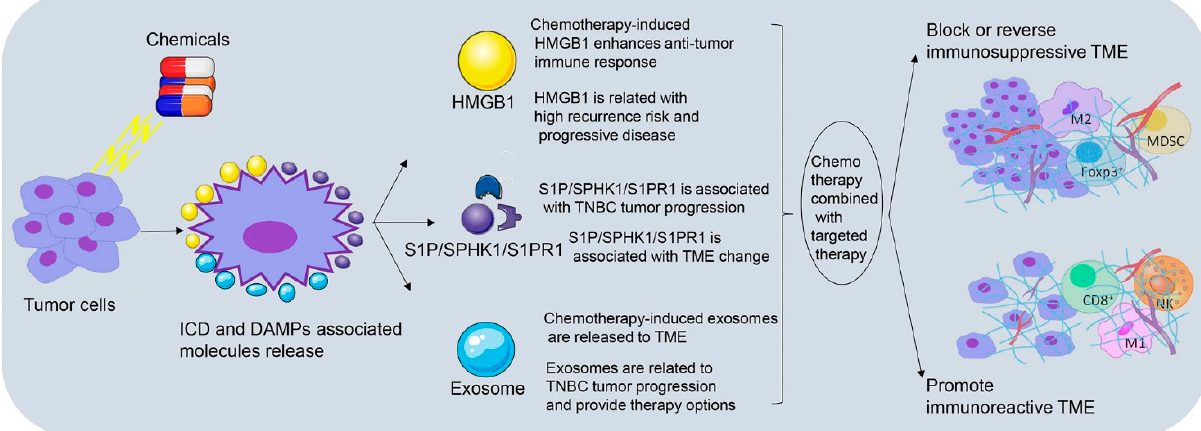
Figure 2. Chemotherapy-induced immunogenic cell death and immunomodulation in TNBC. Chemotherapy induces immunogenic cell death (ICD), and then promotes the release of damage-associated molecular patterns (DAMPs) including high mobility group box1 (HMGB1), exosomes and sphingosine-1-phosphate receptor 1 (S1PR1) by damaged or activated cells. Chemotherapy combined with targeted therapy could enhance anti-tumor immunity through promoting function of immunoreactive lymphocytes and blocking or reversing function of immunosuppressive cells. (ICD, immunogenic cell death; DAMPs, damage-associated molecular patterns; HMGB1, high mobility group box1; S1P, sphingosine-1-phosphate; SPHK1, sphingosine kinase 1; S1PR1, sphingosine-1-phosphate receptor 1; TNBC, triple negative breast cancer; TME, tumor